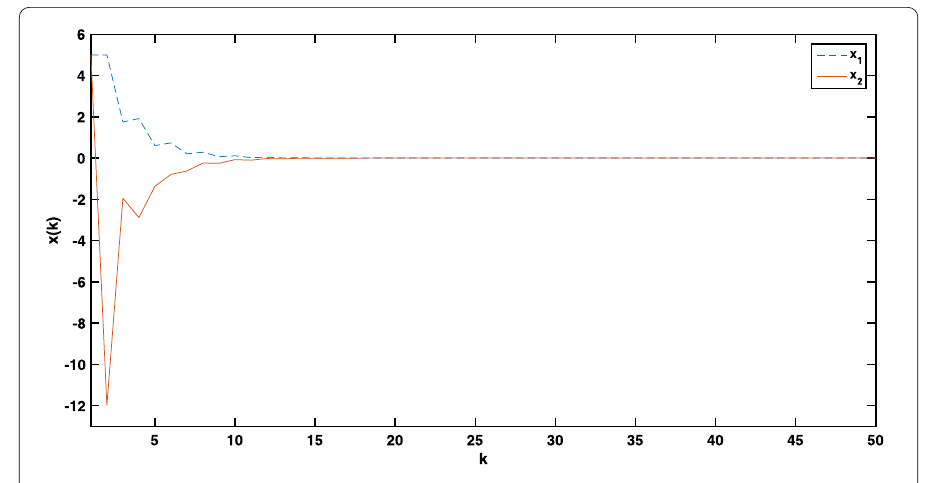
Figure 4 The trajectory of solution of system (2.1) without disturbance